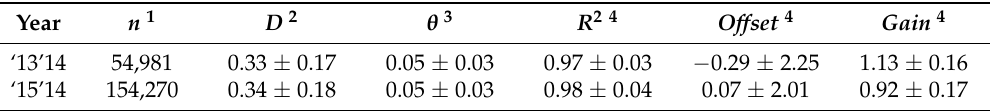
Table 4. Difference indicators and linear correlation results before